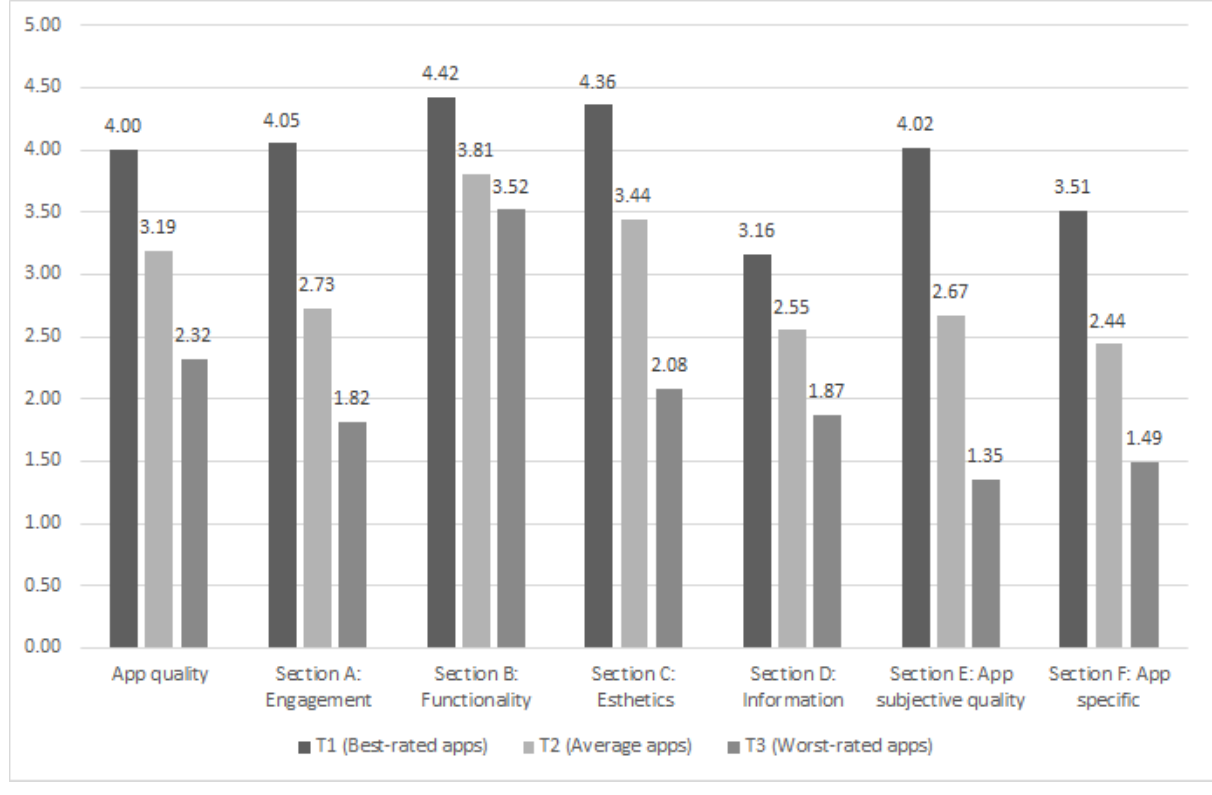
Figure 3. Differences in the mean MARS (Mobile App Rating Scale) scores between